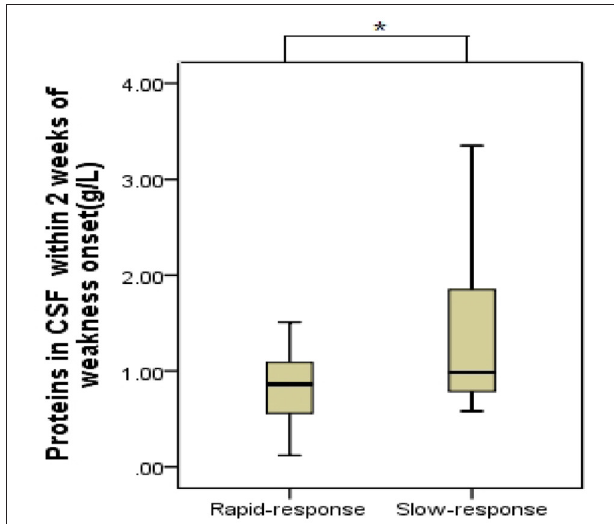
FIGURE 1 | Cerebral spinal fluid (CSF) protein levels in the two groups with Guillain-Barré syndrome. Geometric mean and 95% confidence intervals are shown (box and whiskers: median and 10 – 90% percentile). Slow-response patients (0.99 g/L) had higher CSF protein levels than the rapid-response (0.87 g/L) (* p < 0.05). Rapid-response: treatment response within 7 days; slow-response: treatment response in 8 – 30